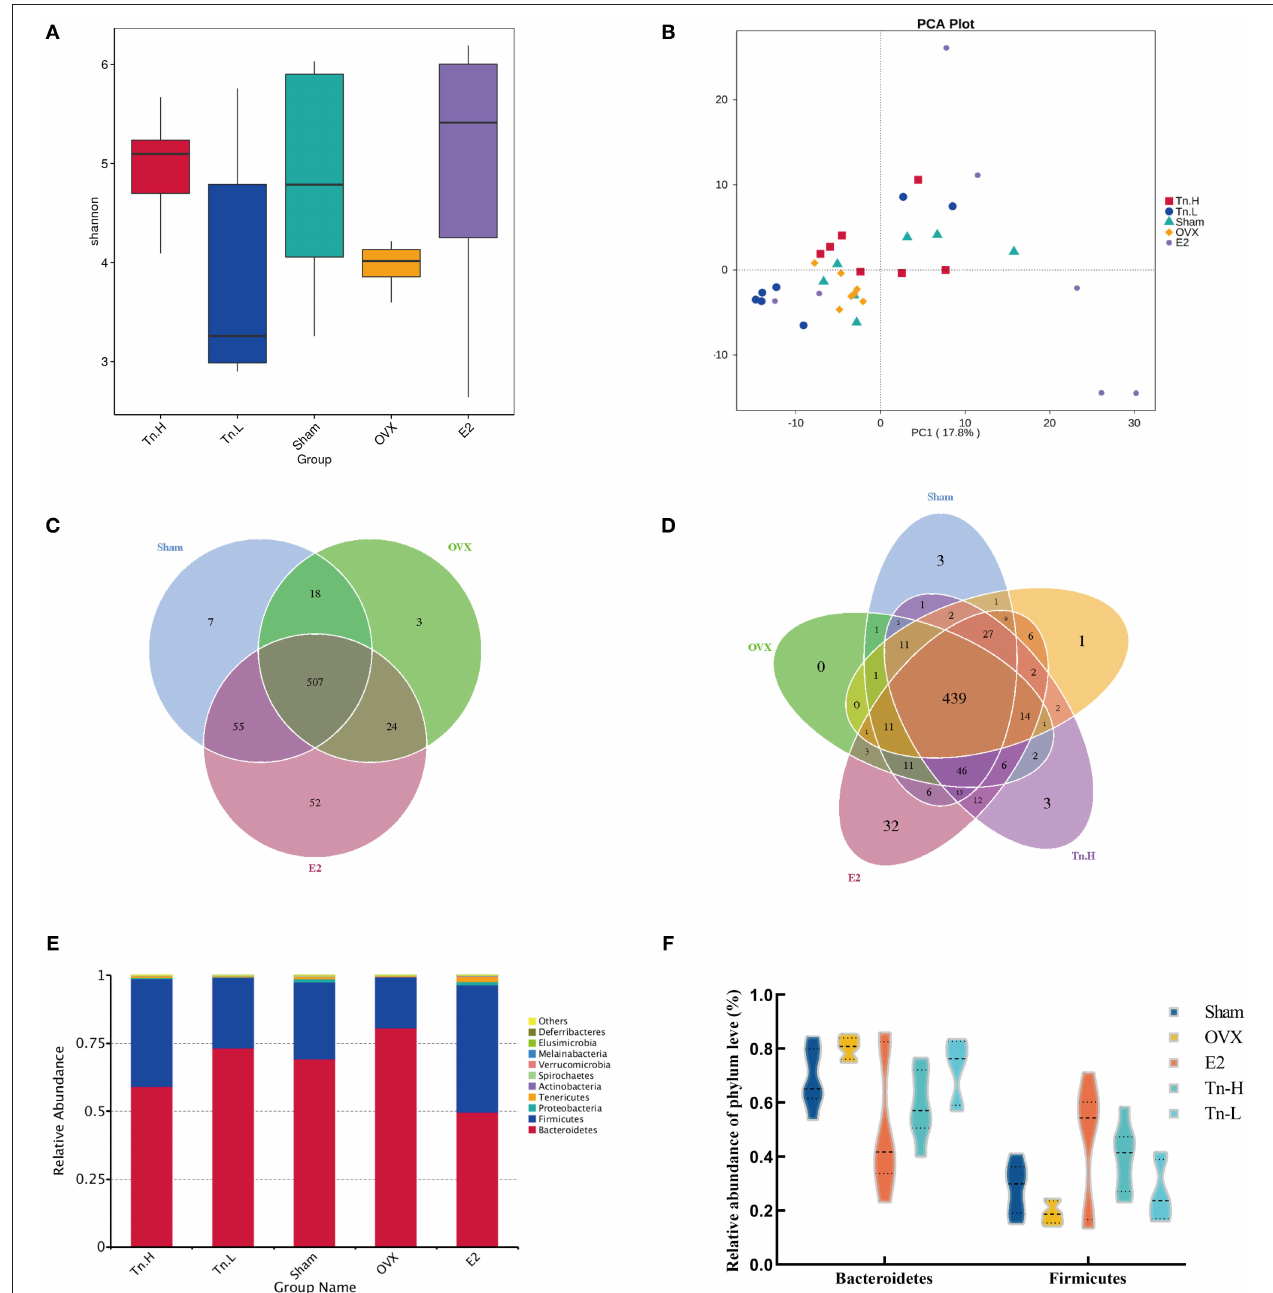
FIGURE 3 | THLs altered gut microbiota in ovariectomized rats. The feces of rats were collected and sequenced, and the community structure was analyzed. Shannon–Wiener species diversity index (A) calculated the alpha diversity. PCA (B) was performed to show the changes in gut microbiota diversity between groups. The number of common and individual OTUs was displayed in Venn diagram (C,D) . Taxonomic classification of the gut microbiome showing the proportion of microorganisms in each group at the phylum level (E,F) . n = 8 per group, Tn-H, high-dose THLs group; Tn-L, low-dose THLs group.